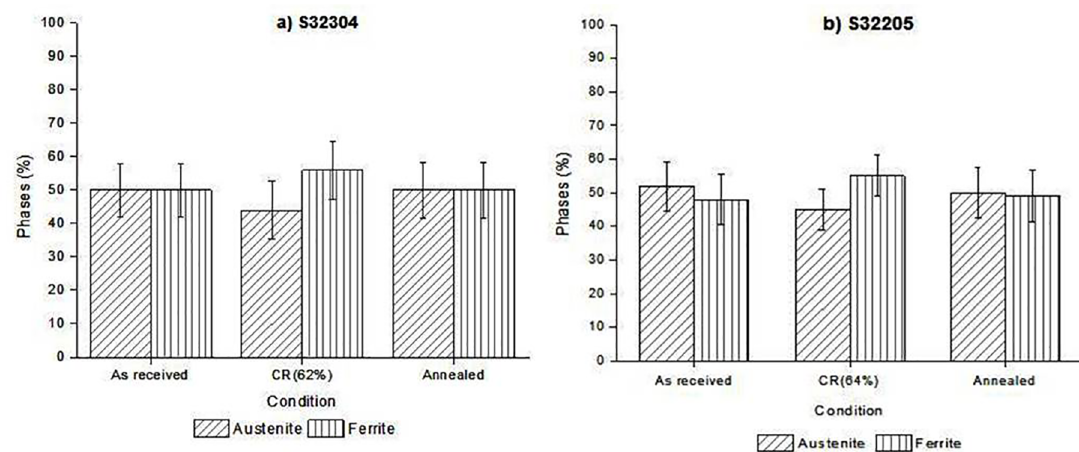
Figure 4. Percentage of the austenitic and ferritic phases of duplex stainless steels; a) S32304 and b)